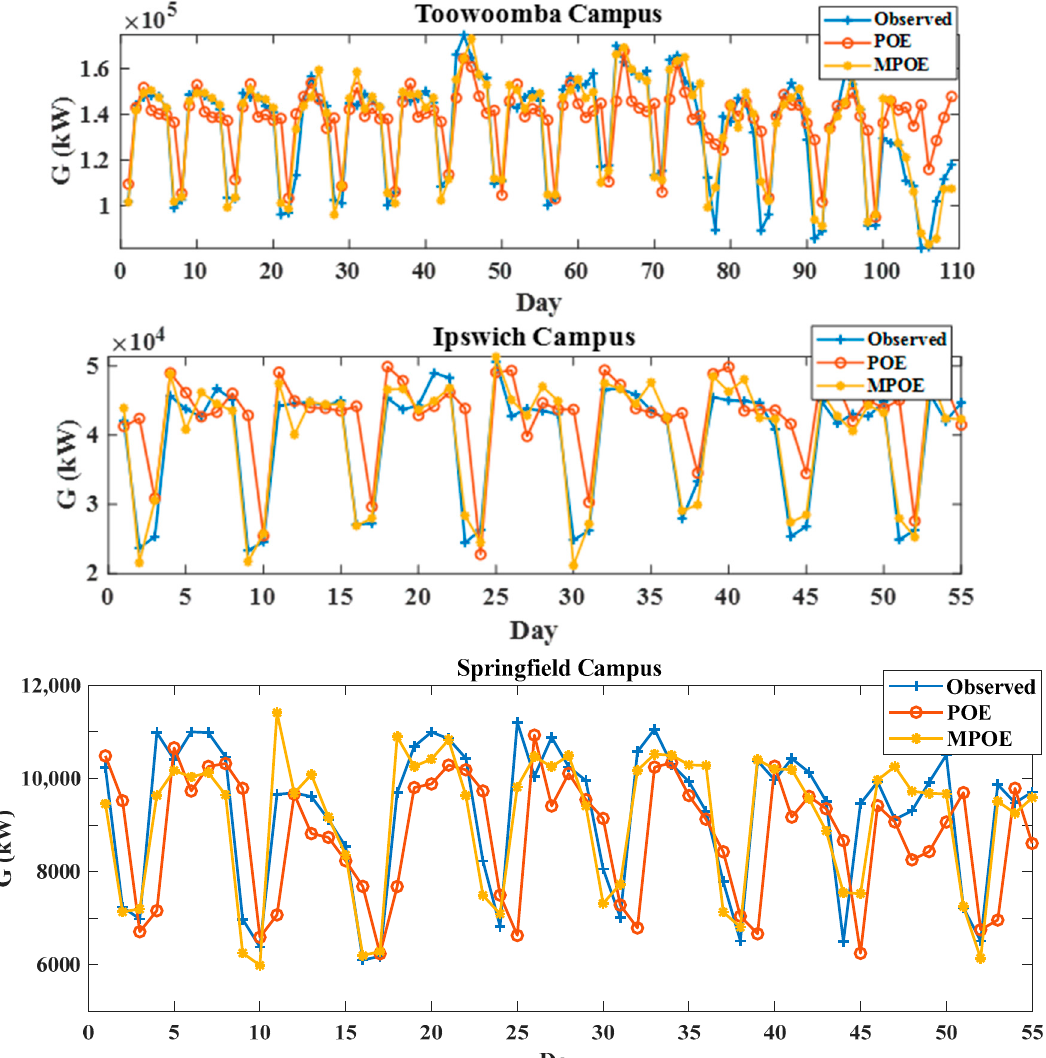
Figure 5. Observed vs. forecasted G data in the testing period with the optimal POE and MPOE models for the three study sites.